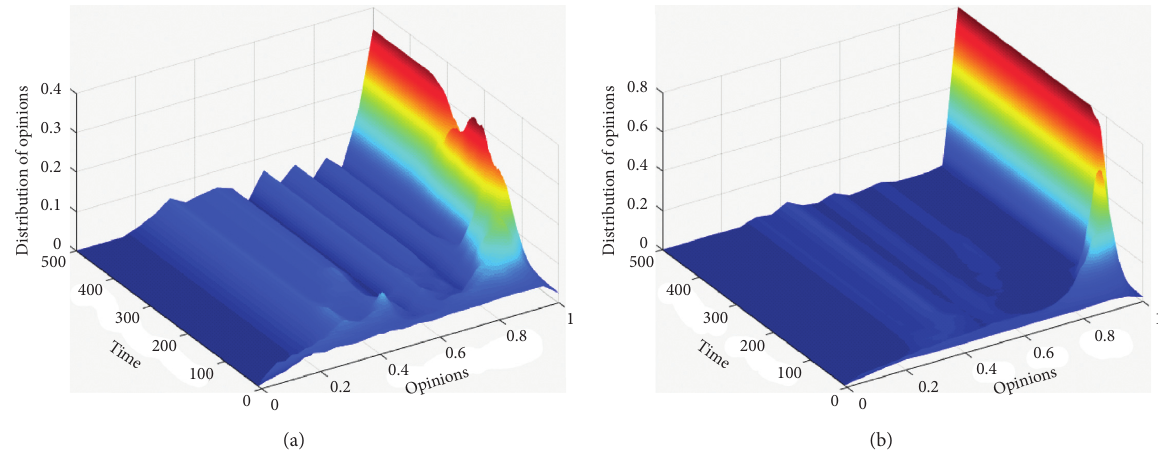
Figure 9: Group opinion distribution evolution in the BA scale-free network. Group polarization is formed when d (b) d m � 0 .